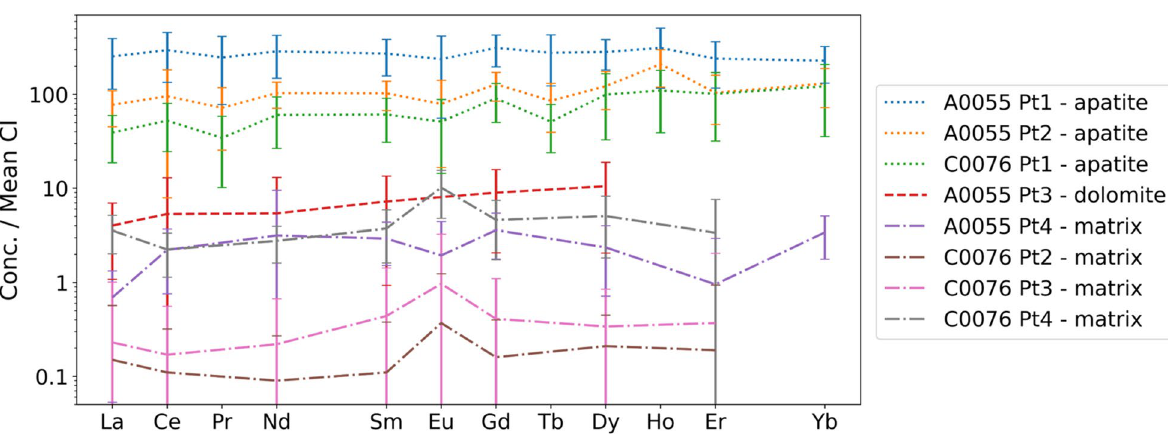
Fig. 6 REE trend of different phases within the Ryugu A0055 and C0076 rock fragments. Error bars indicate three standard error margins (99.7% confidence